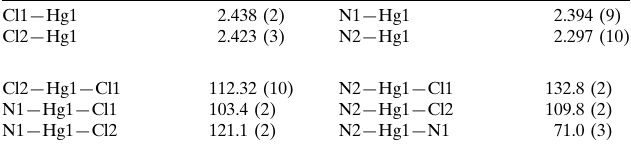
Selected geometric parameters (A˚ , (cid:1)